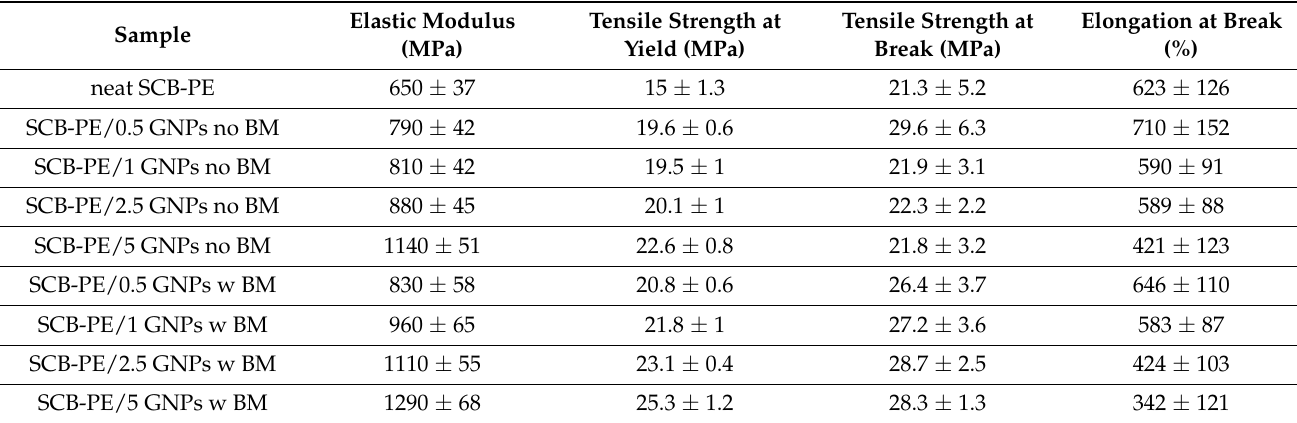
Table 2. Elastic modulus, tensile strength at yield and break, and elongation at break values of neat SCB-PE, SCB-PE/GNPs no BM and SCB-PE/GNPs w BM